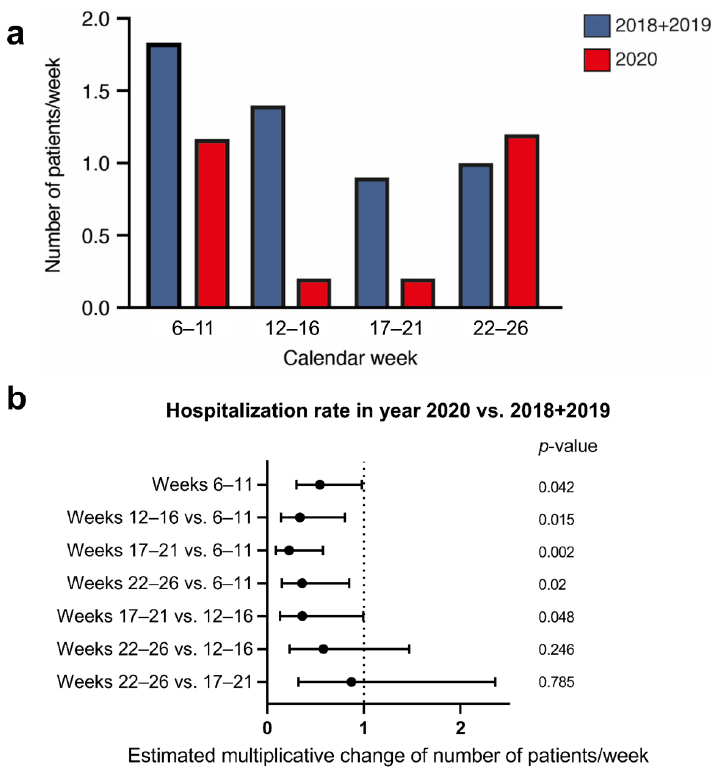
Figure 2. ( a ) Columns demonstrating hospitalization rates for aneurysmal subarachnoid hemor- rhage (SAH) within the calendar weeks 6 to 26 in the years 2018 + 2019 (blue) and in the year 2020 (red). The public shutdown for the COVID-19 pandemic was announced for calendar weeks 12–16. The calendar weeks 6–11 were before, and the weeks 17–21 and 22–26 after, the public shutdown. ( b ) Forest plot visualizing the Poisson regression. The x-axis represents the multiplicative change of the hospitalization rate of SAH-patients at a given time period. Upper bounds of the confidence intervals below one correspond to p -values < 0.05.